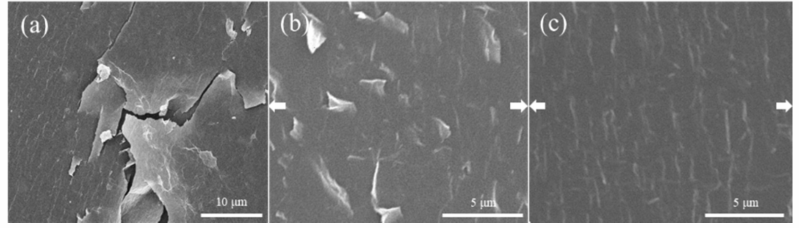
Figure 6. SEM surface images after stretching test on substrates with ( a ) 0%, ( b ) 10%, and ( c ) 30% pre-strain